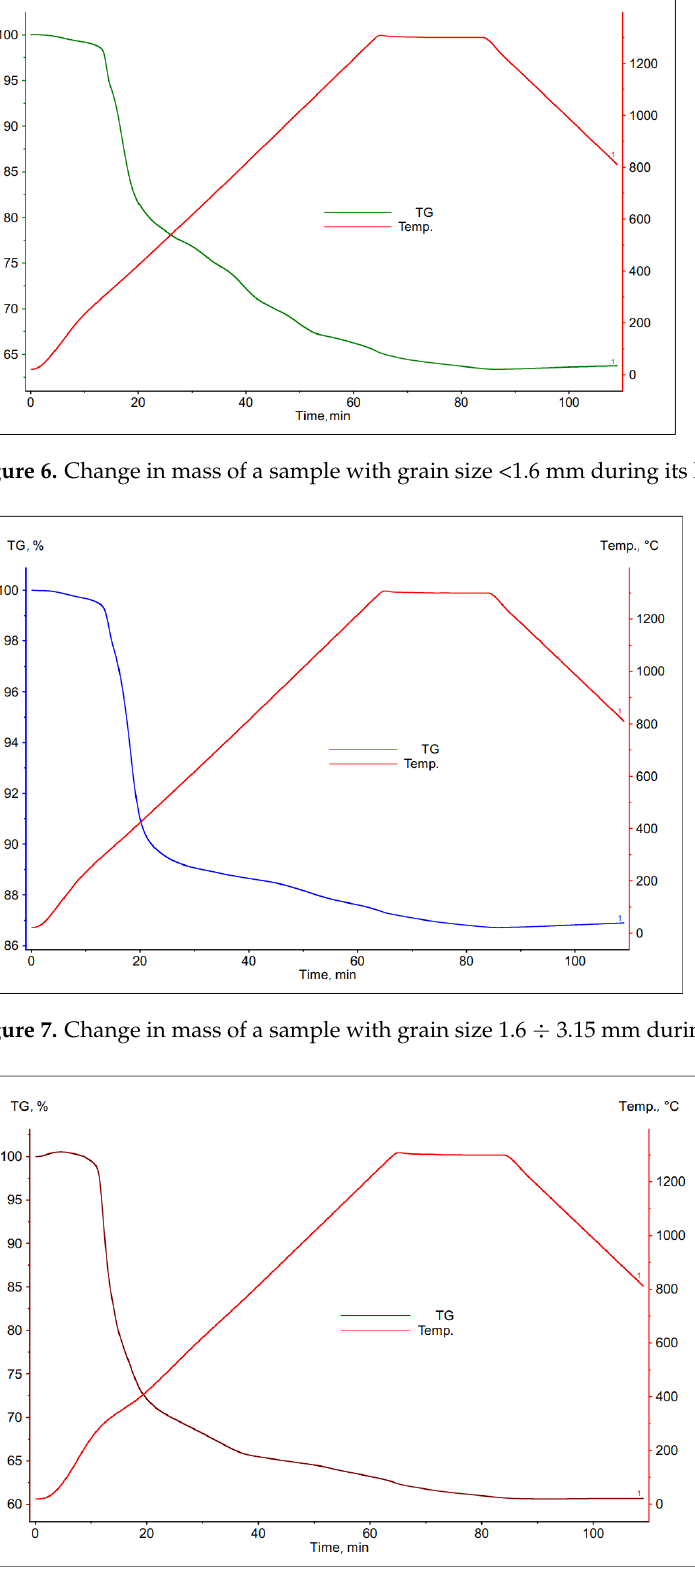
Figure 9. Mass in change of a sample with grain size > 6.3 mm during its heating. Table 4. Recorded weight losses of individual samples. Sample Number